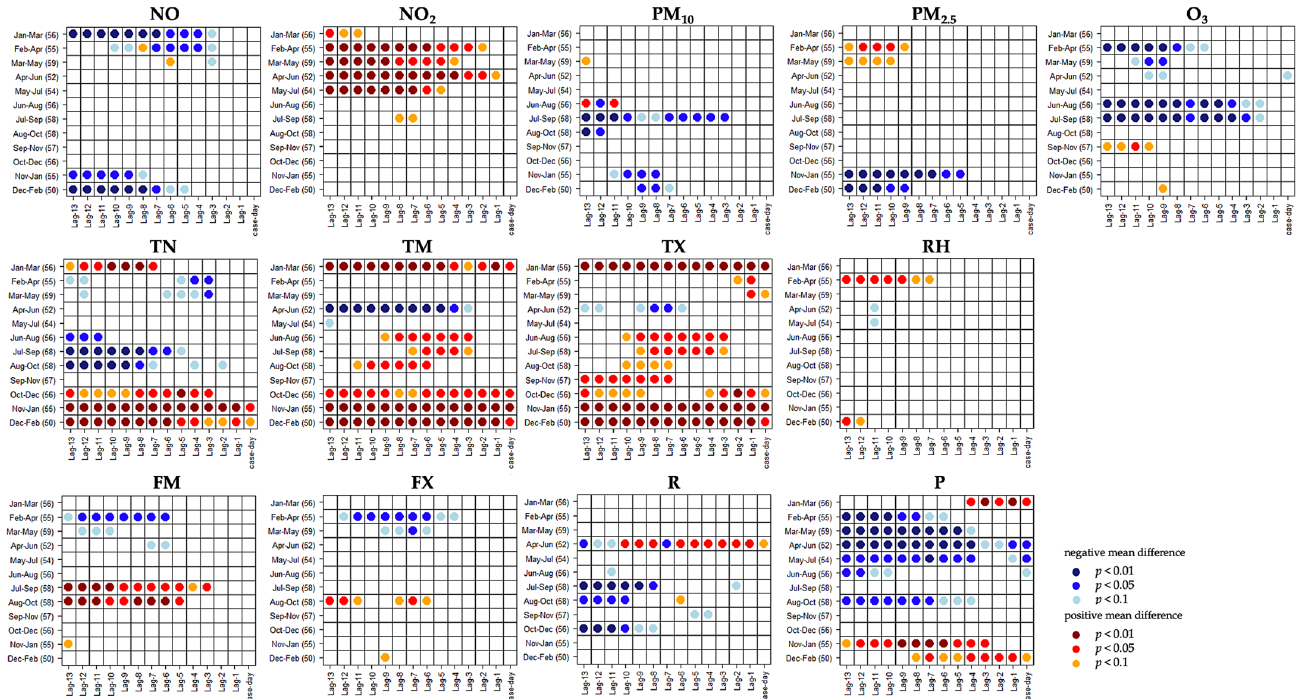
Figure 3. U test results for meteorological and air quality predictors regarding cancer-related mortality events. Monthly windows and up to 13 days prior to each event were considered. Variable abbreviations are listed in Table 1. Numbers next to monthly windows indicate the sum of mortality events within given months. Coloring refers to the mean difference of event-related days minus non-event-related days. Red indicates a significant positive deviation for high-mortality events, while blue indicates a significant negative deviation. P -values of significance are provided for three levels (0.01, 0.05, 0.1). Table 2. Composites of contemporaneous significant predictors in advance of high-mortality events, as suggested by U testing. Only health-relevant predictors of airborne substances and temperature are